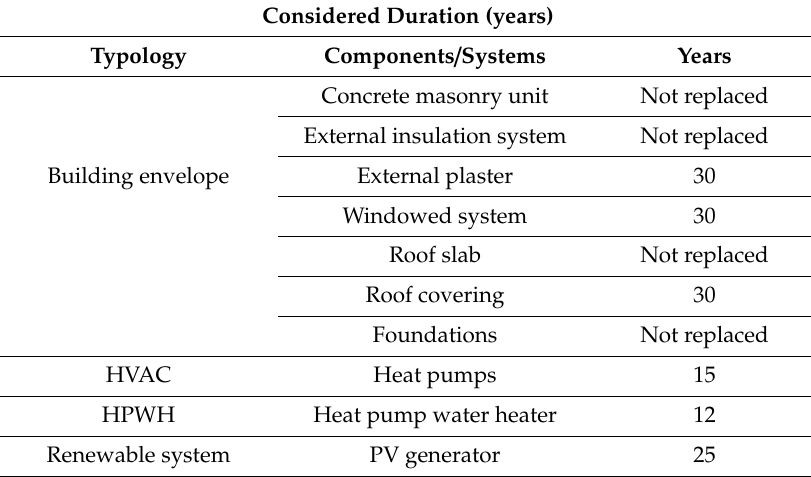
Table 8. Replacement times assumed for the main building–plant system components in a lifespan of 30